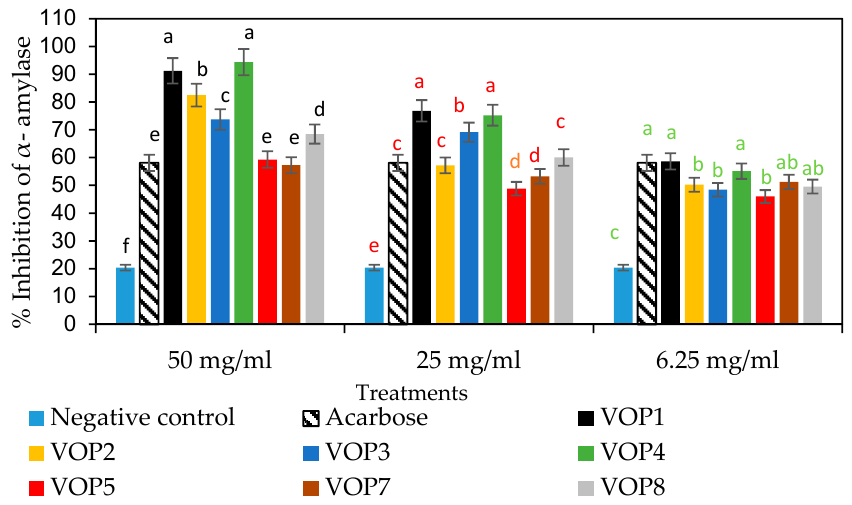
Figure 7. Percentage inhibition of leaf extracts of cowpea cultivars against α -amylase activities. Bars representing the enzyme activity for a specific leaf extract concentration. Bar with same alphabets are not significantly di ff erent between cultivars at p < 0.05. Data obtained were subjected to analysis of variance (ANOVA) using the statistical programme. Each bar represents the mean and standard deviation ( n = 3).